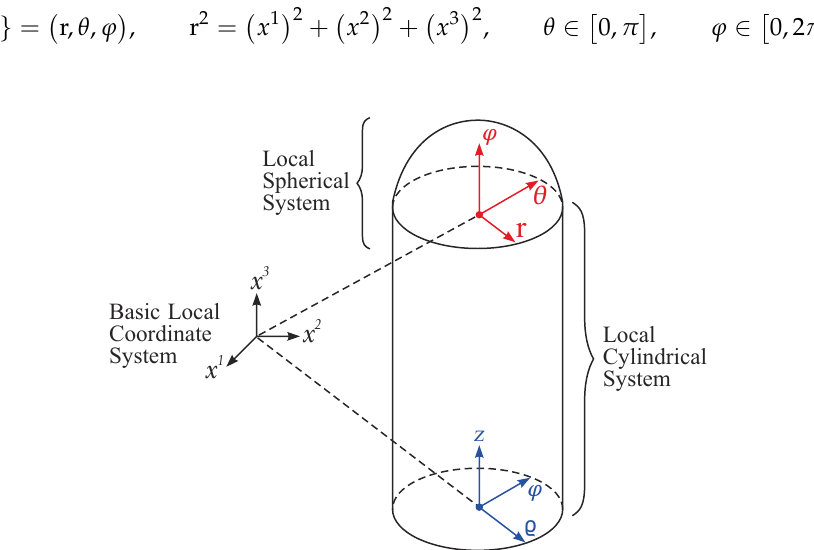
Figure 5. When constructing the representation on the atlas card, a rectangular local coordinate system